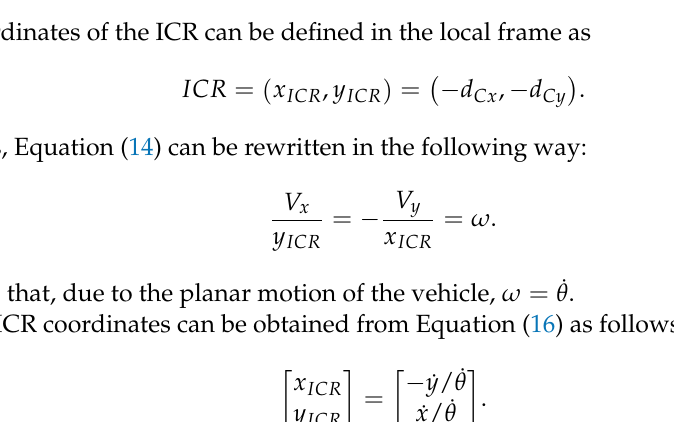
Figure 4. Instantaneous center of rotation